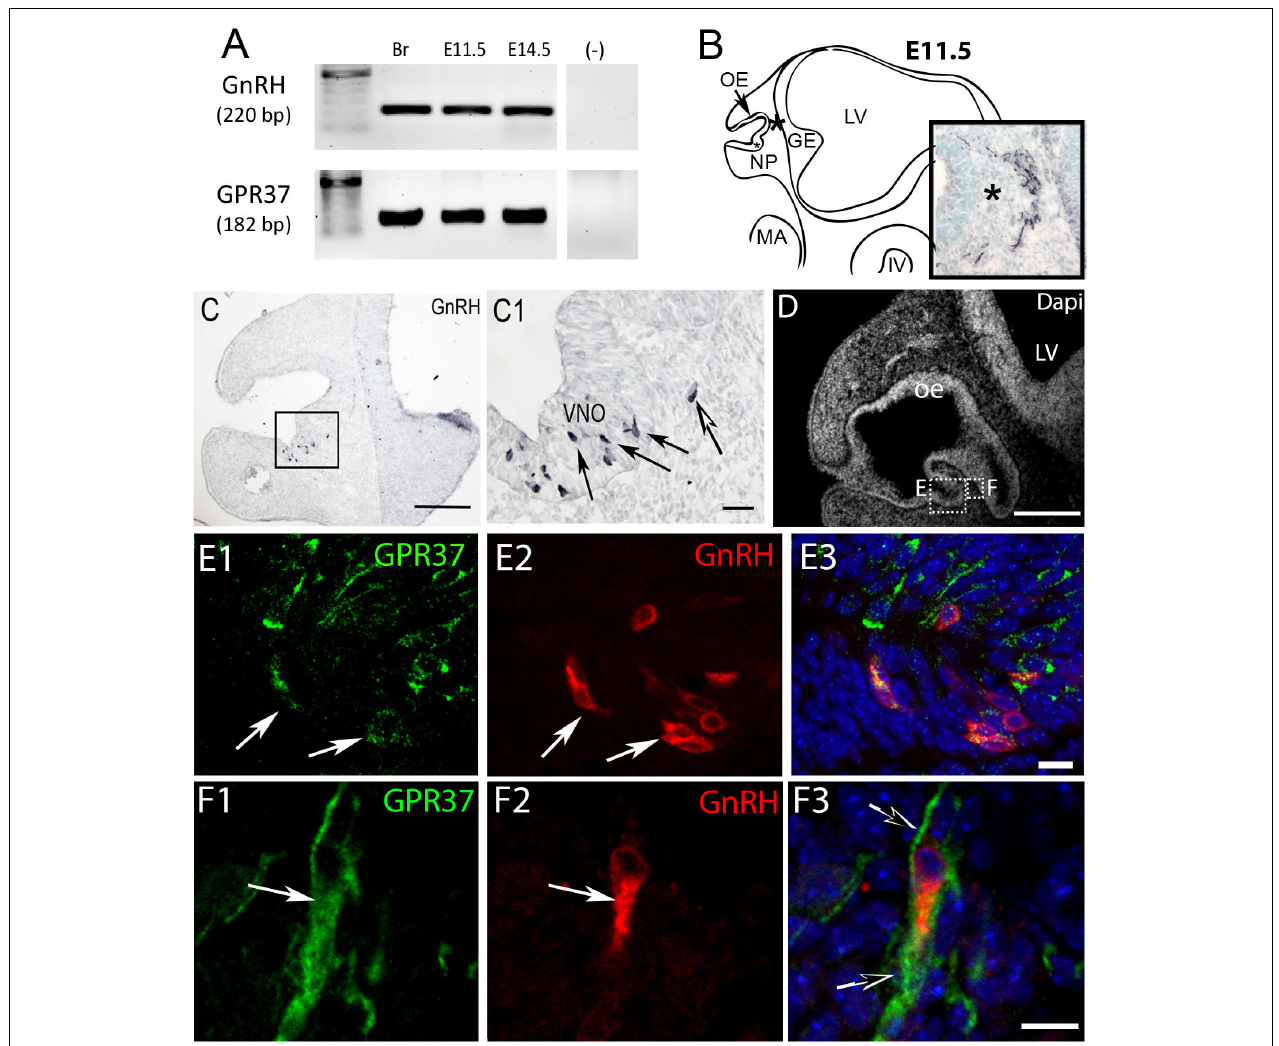
FIGURE 1 | GPR37 is expressed in developing GnRH neurons. (A) GPR37 transcript (182 bp) was detected in Adult brain (Br), E11.5 nose, and E14.5 nose. Positive control GnRH transcript (220 bp); Negative control water ( − ). (B) Schematic of E11.5 embryo (NP, nasal pit; OE, olfactory epithelium; GE, ganglion eminence; LV, lateral ventricle; MA, mandibular process; IV, fourth ventricle) showing location of cells expressing GPR37 in the migratory mass (blue black staining photomicrograph inset; same location in schematic and inset indicated by asterisk). Cells in the migratory mass originate in the nasal placode. (C) Chromogen immunocytochemistry on E11.5 mouse sections stained for GnRH. GnRH expression is robustly detected in cells in the nasal pit (black arrows in C1 which is boxed area of C ) as well as cells that have started to migrate (white arrow in C1 ). (D–F) Immunofluorescence staining for GPR37 (green) GnRH (red) and Dapi (white in D , blue E3 , F3 ). (D) Low magnification showing nasal area from which E and F are taken. (E,F) Low levels of GPR37 were detected in GnRH cells in the nasal pit ( E , white arrows), while stronger GPR37 staining was detected in migrating GnRH cells ( F , white arrow), as well as other elements associated with the migration route ( F3 , black arrows). Scale bars: (C,D) = 100 mm, (C1,D1) = 50 µ m, (E,F) = 10 µ